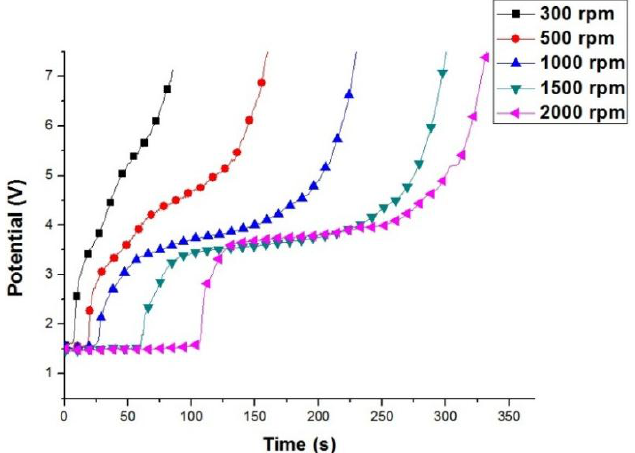
Figure 2. Potential variation of the AZ80 RCE at different rotation speeds during the galvanostatic etching at the current density of 20 mA·cm −2 in an alkaline Cu plating